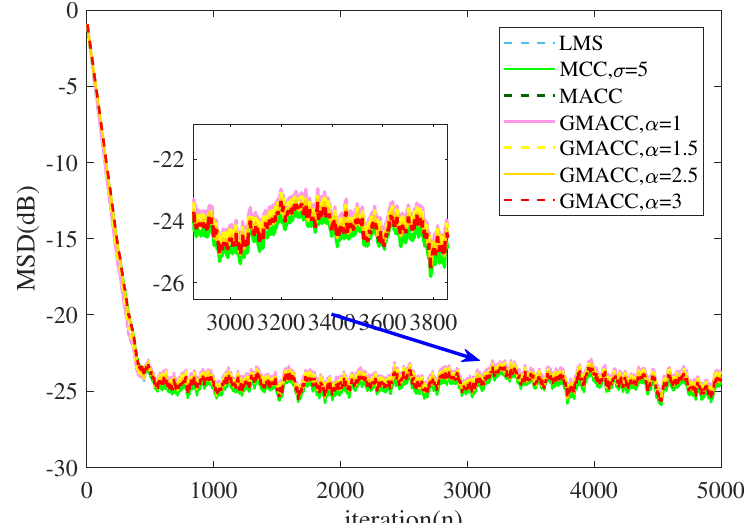
Figure 11. Steady-state performance comparison of different algorithms under asymmetric Gaussian distribution